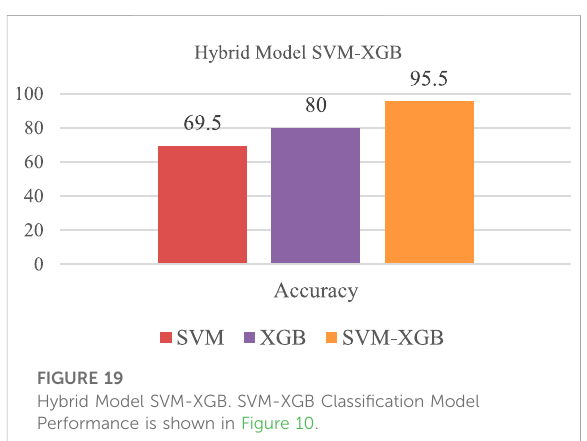
FIGURE 19 Hybrid Model SVM-XGB. SVM-XGB Classi fi cation Model Performance is shown in Figure 10.